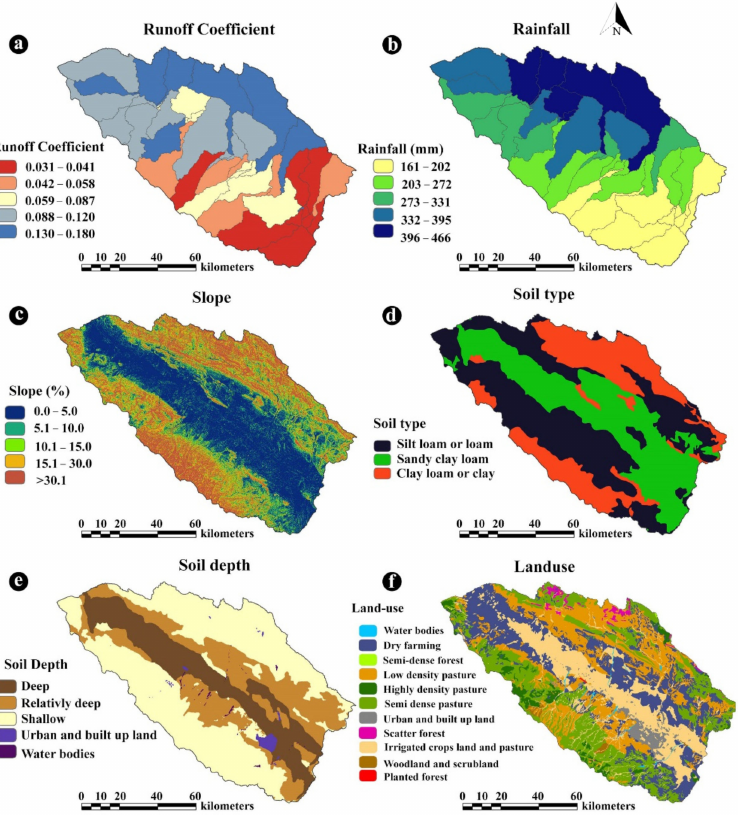
Figure 3. Layers and corresponding feature classes. ( a ) Runoff coefficient, ( b ) rainfall, ( c ) slope, ( d ) soil type, ( e ) soil depth, and ( f ) land